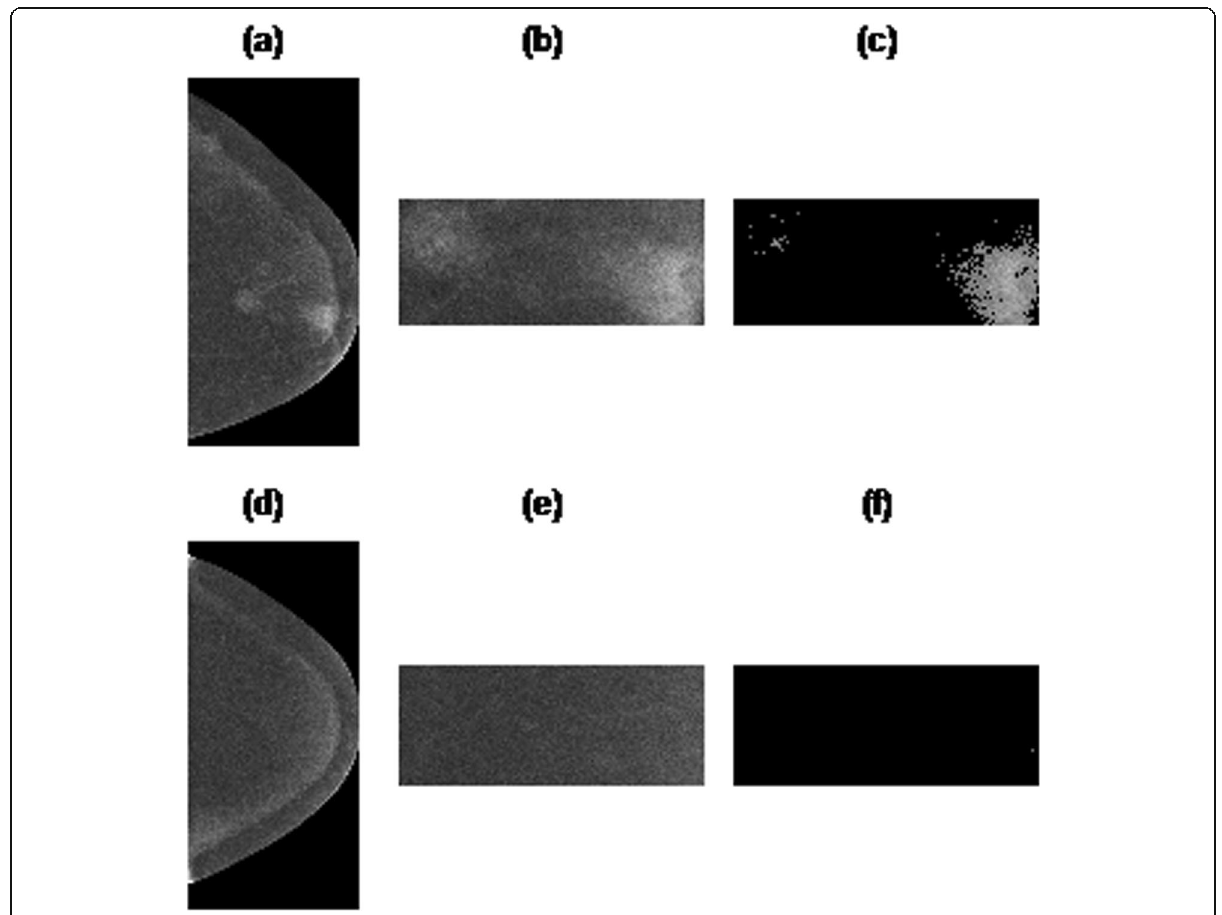
Fig. 1 a , d The original image. b , e The suspicious region and c , f after applying thresholding